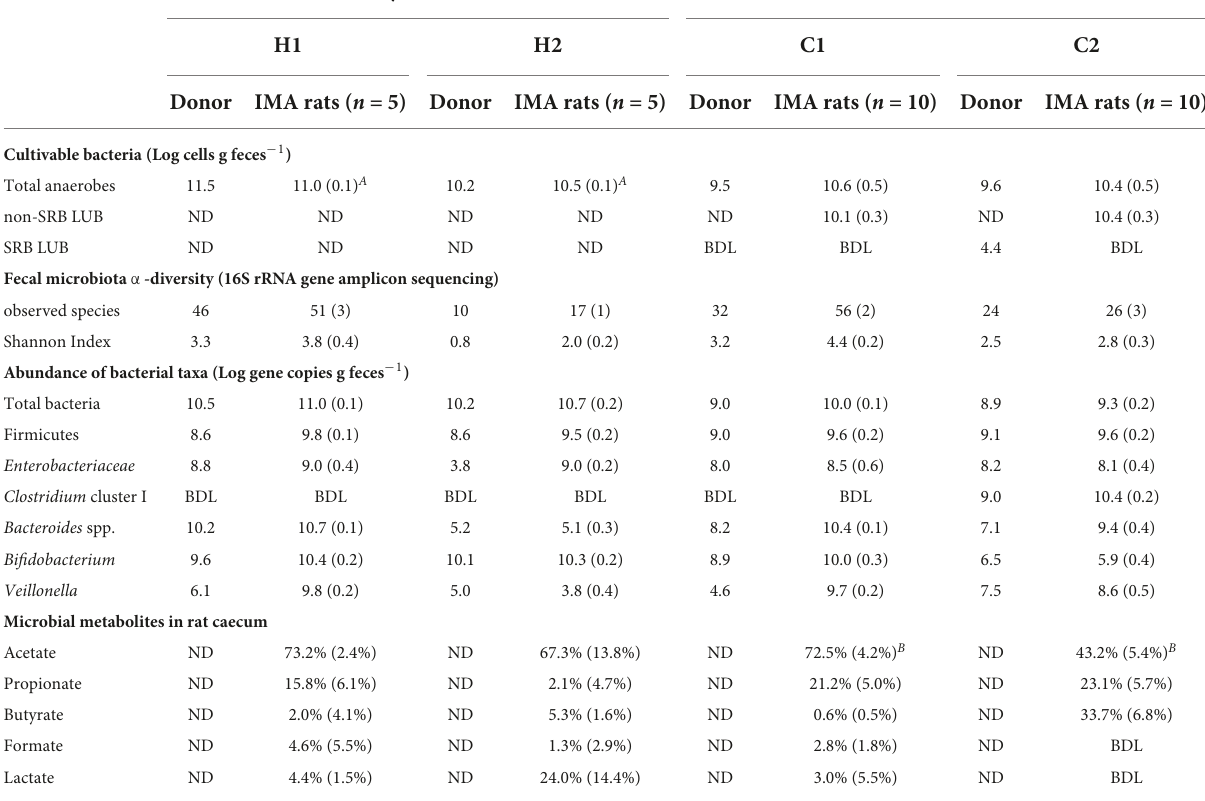
TABLE 1 Main bacterial communities in feces from infant donors and IMA rats at baseline and fermentative metabolites in cecal supernatant from IMA rats after euthanasia.